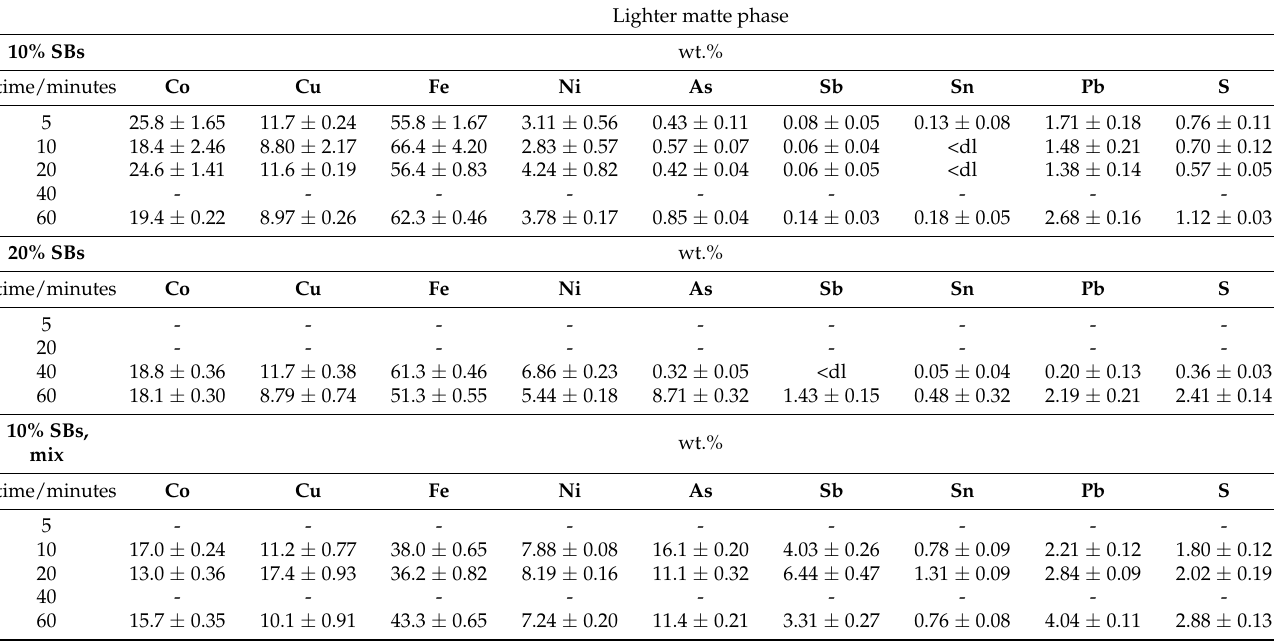
Table A4. Chemical composition of lighter matte phase analyzed with SEM-EDS. Lighter matte phase